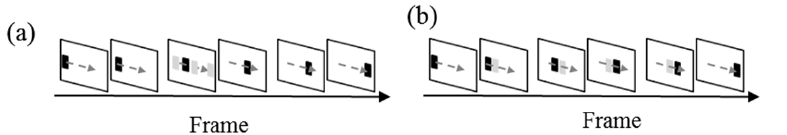
Figure 3. Schematic illustration of moving target with flashed false targets. ( a ) A single moving target with flashed false targets in time. ( b ) A single moving target with flashed false targets in space.